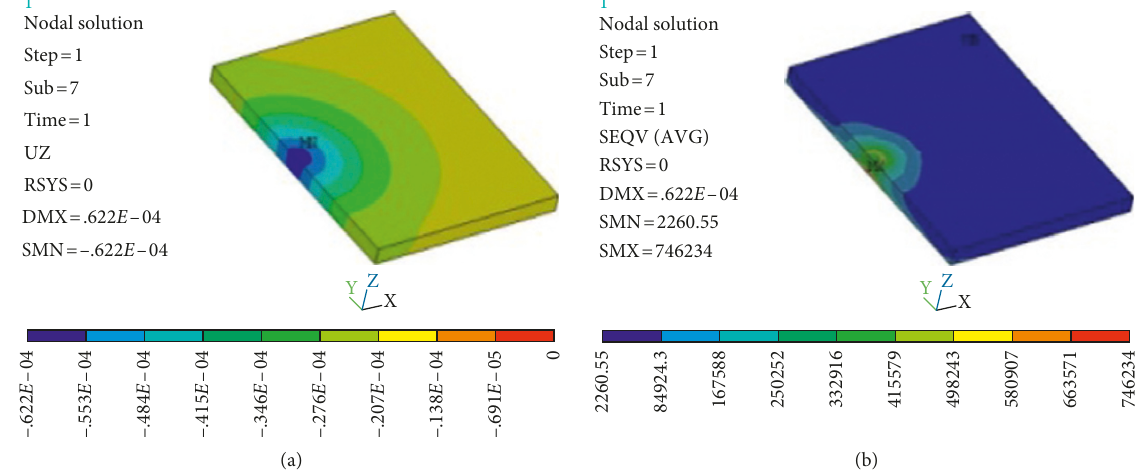
Figure 12: Aircraft deflection and stress cloud diagrams: (a) original surface layer deflection cloud diagram; (b) original surface layer stress cloud diagram.